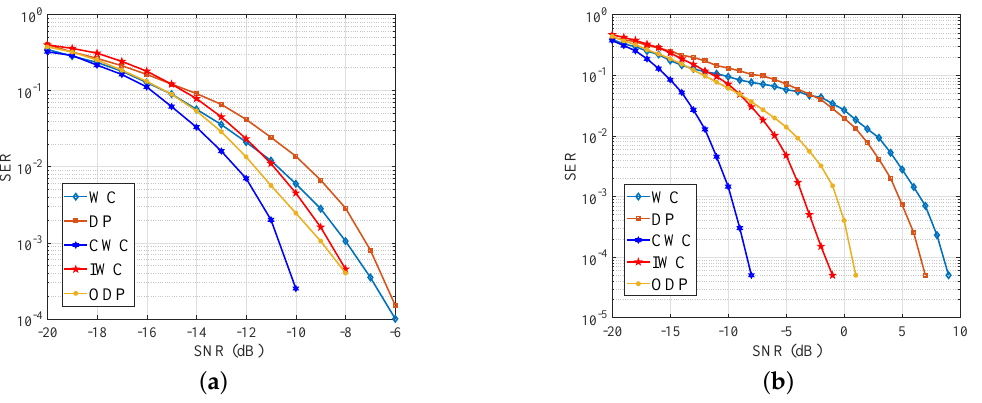
Figure 9. Comparison of communication reliability. ( a ) Signal-to-interference ratio (SIR) = − 25 dB ( b ) SIR = − 30 dB.